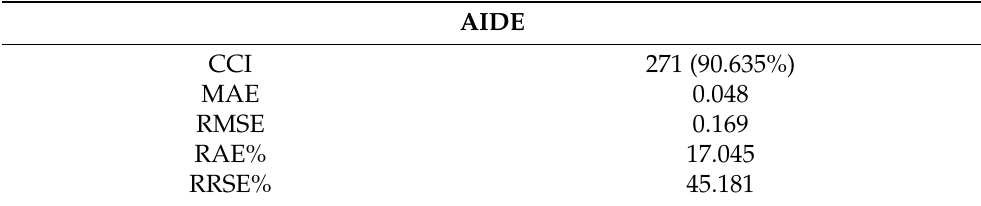
Table 7. CCI and Error Rates details achieved via